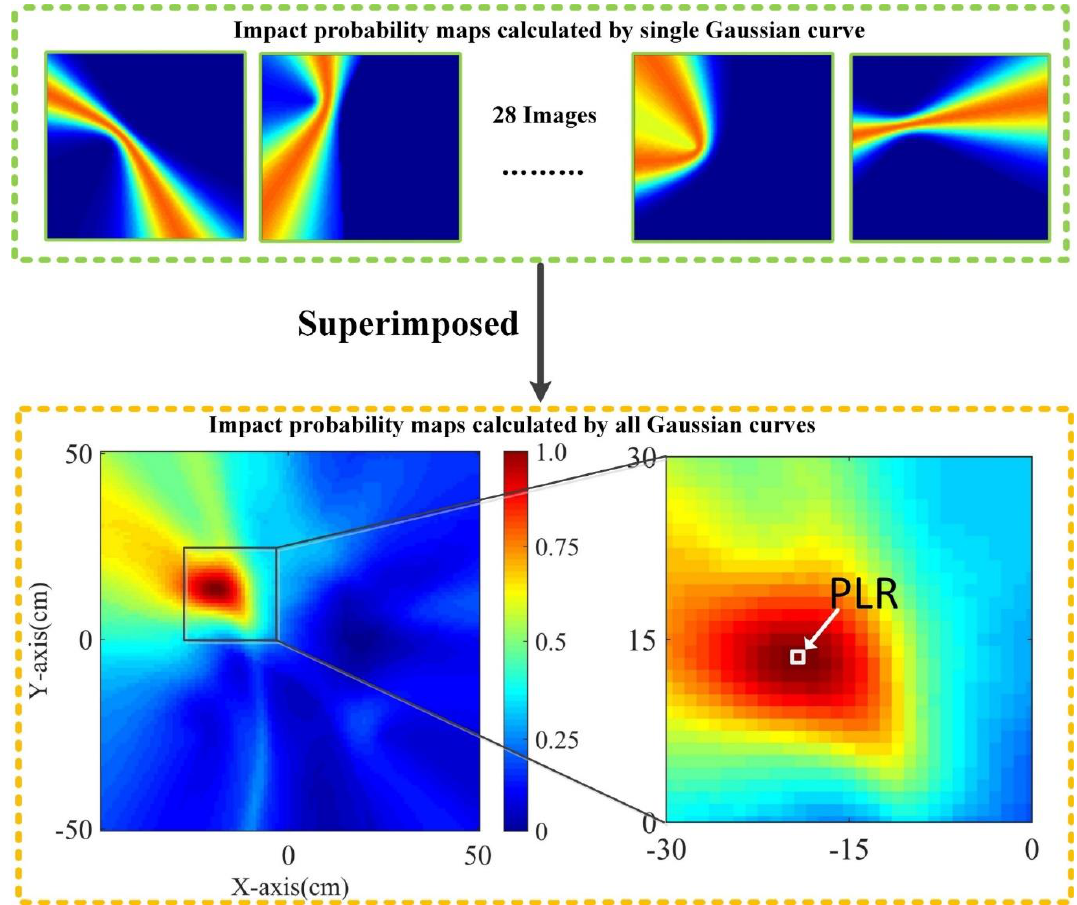
Figure 10. Impact possibility weight maps-drawing process.